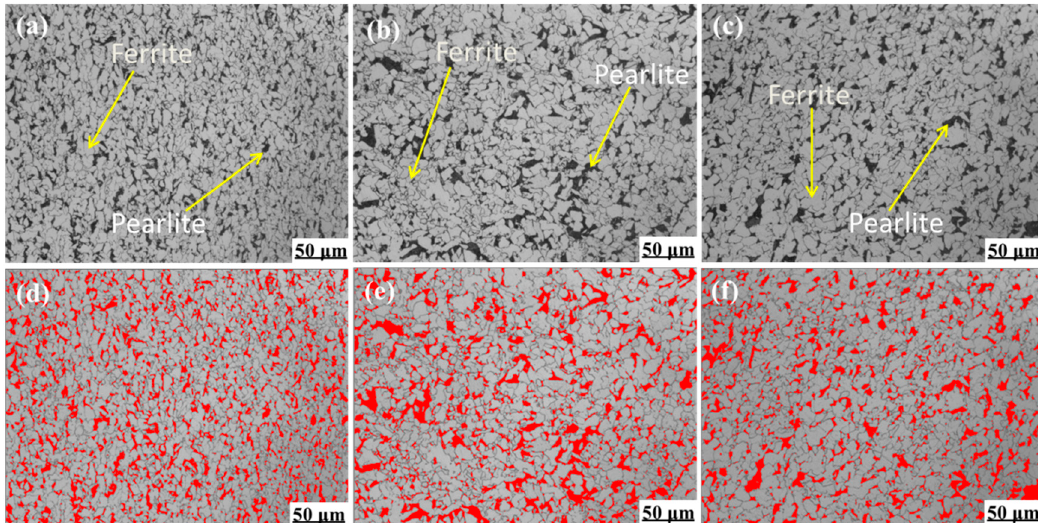
Figure 3. Metallographic microstructure of experimental steel under different final cooling tem- peratures after five passes of thermal simulation. ( a , d ) 650 °C; ( b , e ) 700 °C; ( c , f ) 750 °C. Through thermal simulation experiments, the optical microstructure of the steel is shown in Figure 3. The tested steel is mainly composed of polygonal ferrite and pearlite.